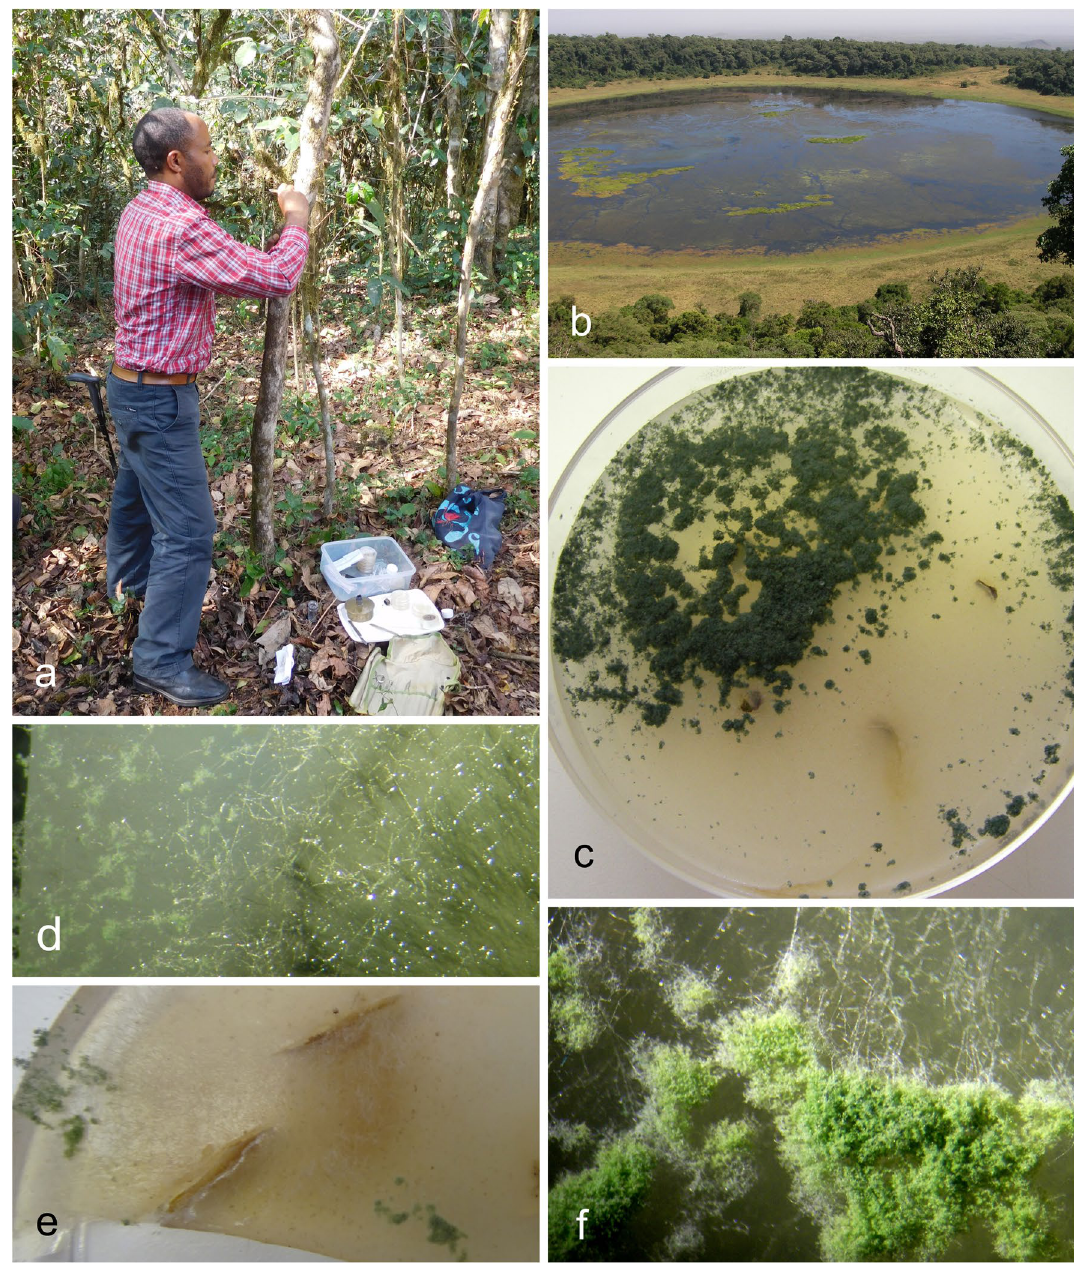
Figure 13. Survey protocol and isolates of Trichoderma . ( a ) Kifle Belachew isolating endophytes directly from main stem of Coffea arabica in a semi-wild coffee farm in the Kaffa Zone of Ethiopia. ( b ) Lake Paradise in Marsabit Forest Reserve, Eastern Province of Kenya where wild Coffea cf. arabica is common in the understorey. ( c – f ) Trichoderma isolates growing from Marsabit coffee stem samples, including Trichoderma lentissimum sp. nov. ( e